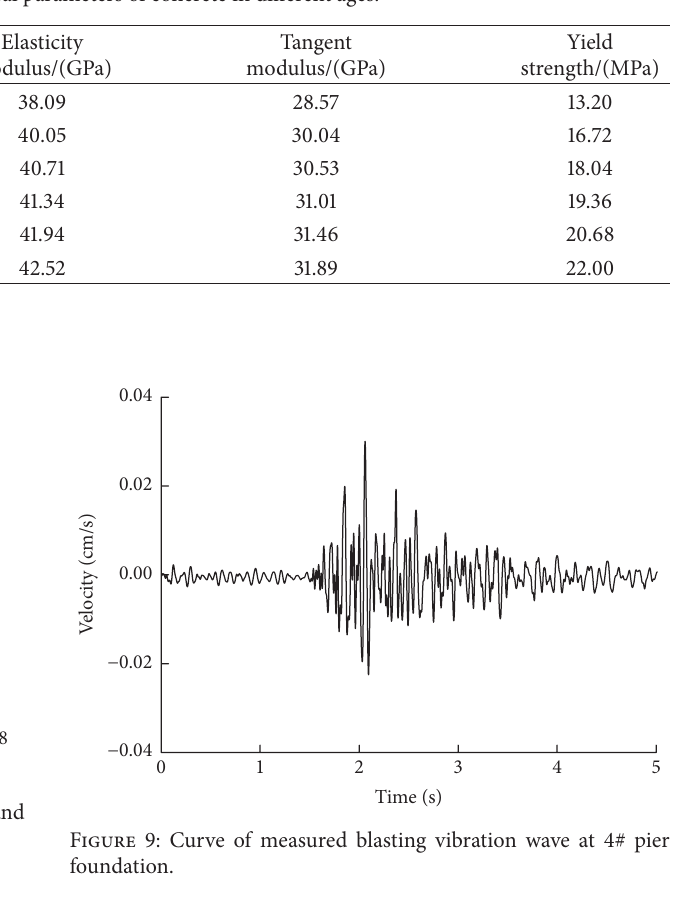
Table 4: Physical and mechanical parameters of concrete in different ages.